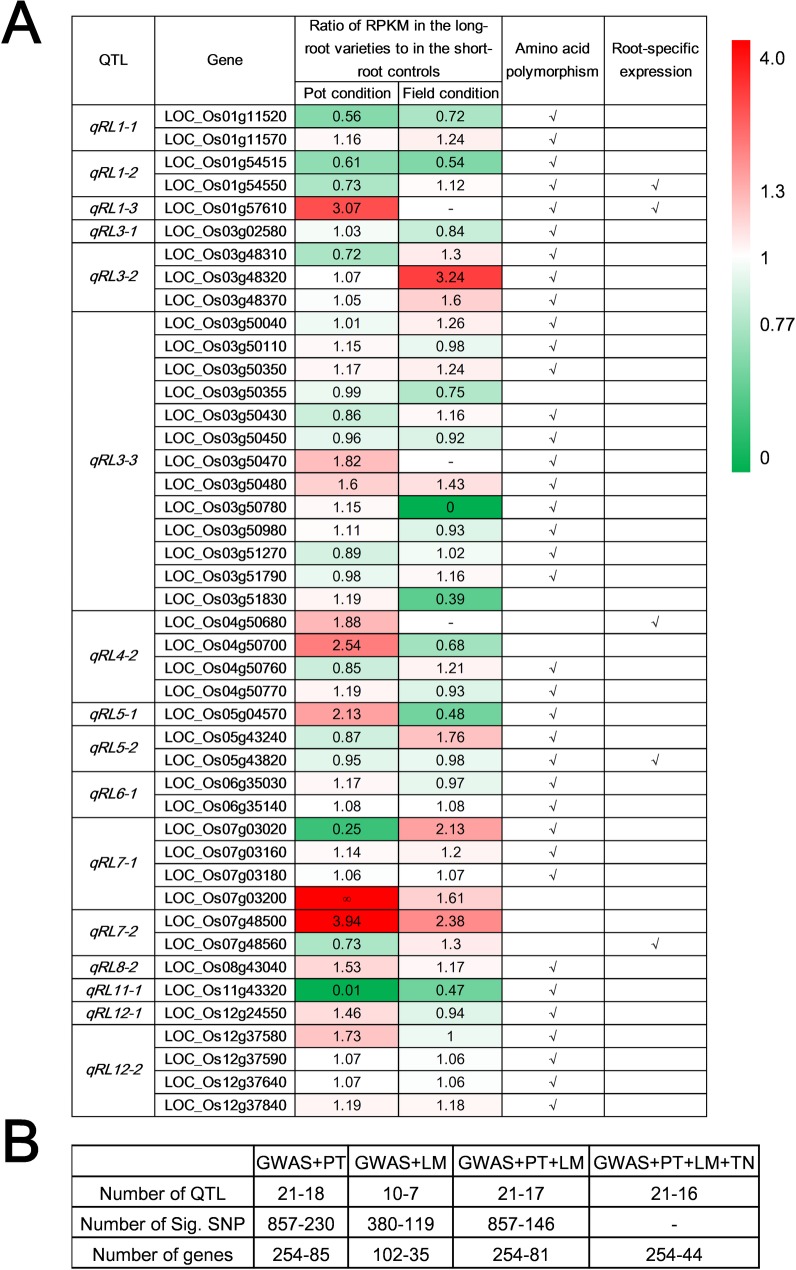
Determination of candidate genes for root-length QTLs by integrated genomic and transcriptomic analyses.(A) Heat map of the RPKM ratio in long-root varieties to short-root controls. Different colors show ratios and blanks indicate no expression. Rows of the heat map correspond to the 44 candidate genes for root length QTLs listed on the left of the table. The columns indicate the phenotypic differences between the long-root and short-root pools in the pot and field conditions. √ or × in column ‘Amino acid polymorphism’ indicates the presence or absence of large-effect SNPs/InDels and the significant phenotypic differences between the varietal pools of extreme phenotypes, parents or populations; column ‘Root-specific’ shows the root-specific expression of the listed genes. Detailed expression and large-effect SNPs/InDels with amino acid polymorphisms are listed in S11–S13 Tables. (B) Screening effectiveness of each step in the integrated strategy. ‘PT’, ‘LM’ and ‘DE’ indicate ‘pooled-χ2-tests’, ‘linkage mapping’ and ‘transcriptomic and non-synonymous SNPs analysis’. Numbers in the block represent the number of QTLs, significant SNPs and candidate genes before and after screening.